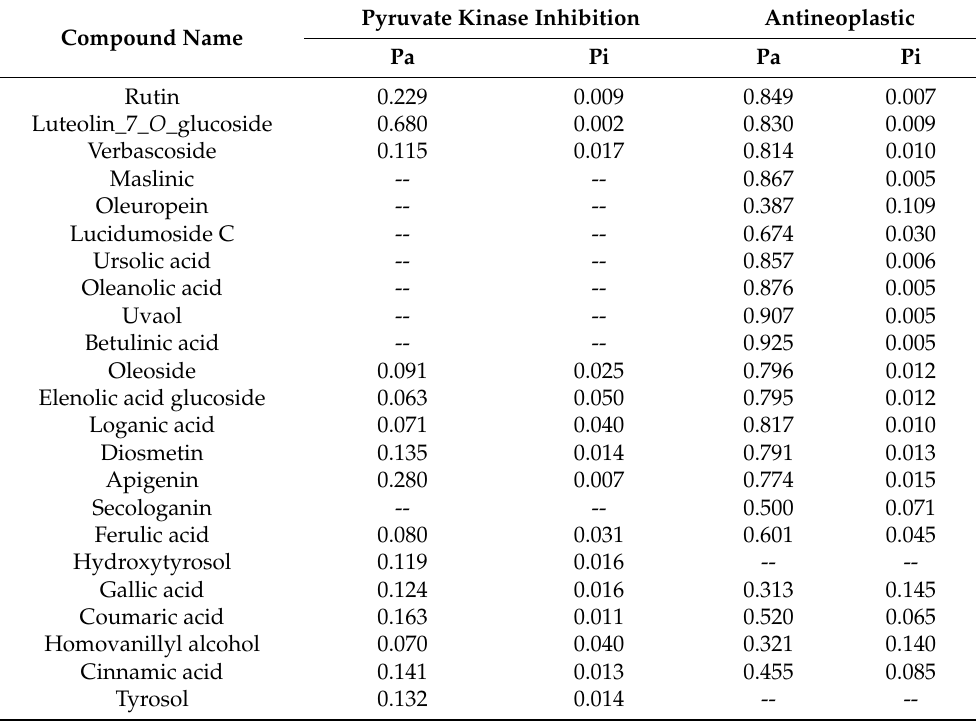
Table 4. Anti-cancer predictions of the phytocompounds present in the olive leaf extract (OLE) using Way2Drug (pass)